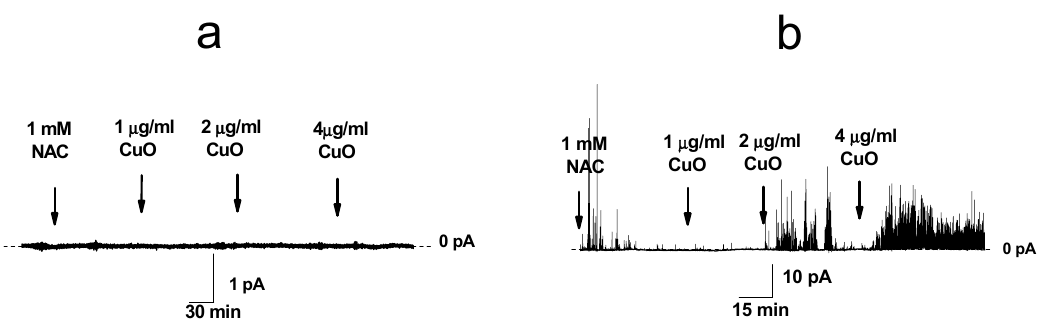
Figure 4. Examples of current fluctuations induced by CuO NPs (1–4 µ g/mL) and NAC (1 mM) in lipid bilayers composed of POPC ( a ) and POPG ( b ) and bathed in 0.1 M KCl pH 7.4. The transmembrane voltage was 50 mV. Arrows indicate the addition of NAC or CuO NPs into the membrane bathing solution. One experiment out of three replicates with essentially the same results is shown.